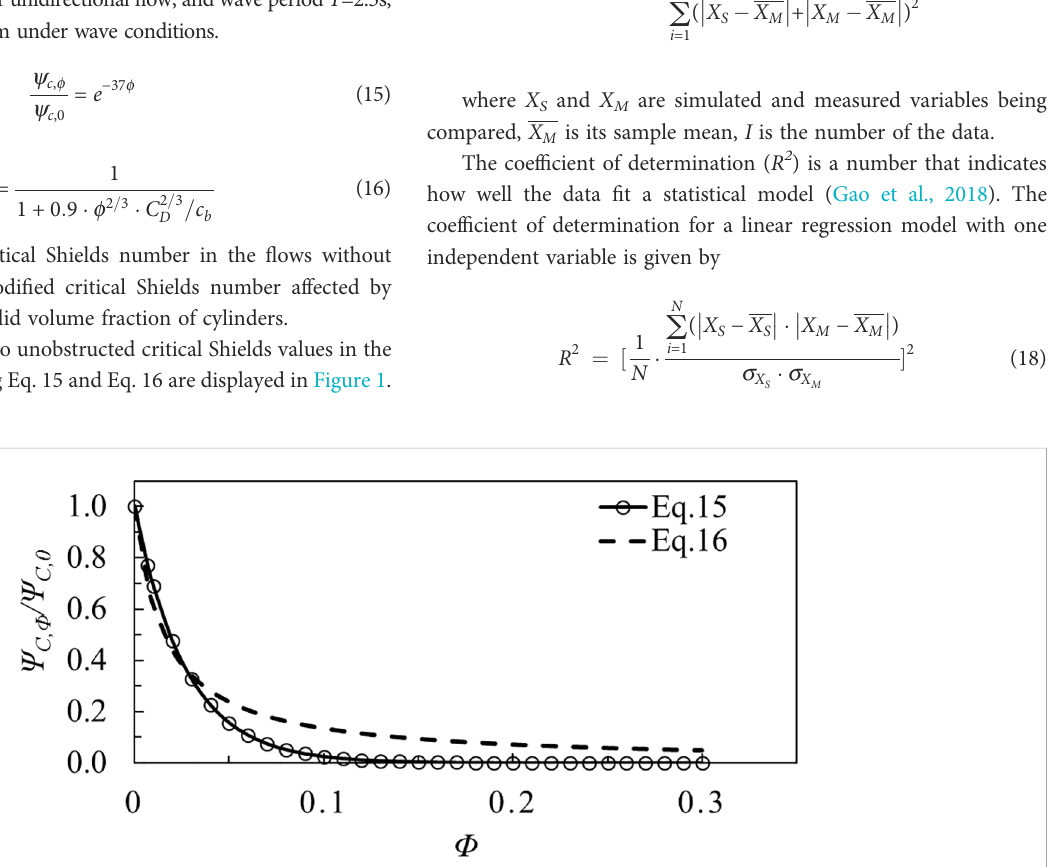
FIGURE 1 Ratios of obstructed to unobstructed critical Shields values in the fl ow with